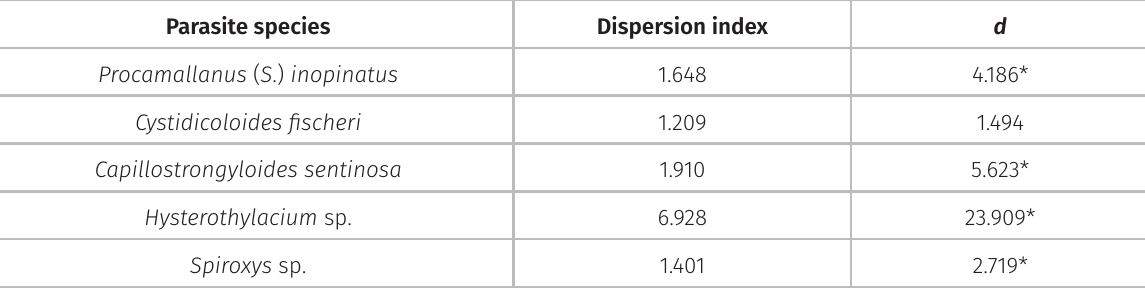
Table III. Values of the dispersion index and the statistical d -test of the metazoan endoparasites of Pygocentrus piraya from Três Marias reservoir, upper São Francisco river, state of Minas Gerais,